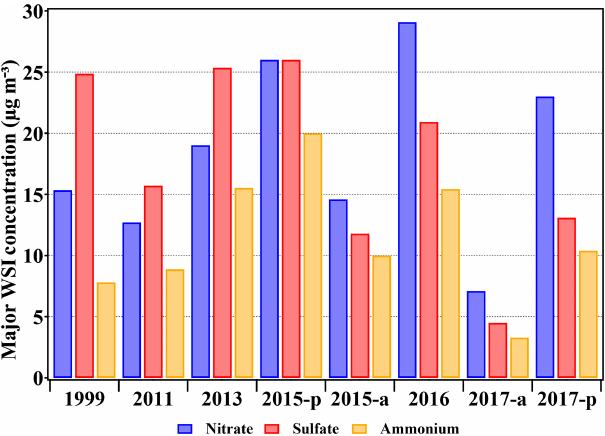
Figure 5. Ratio N-to-S and Ratio A-to-S calculated from the averaged data reported in representative research articles. Only the data in pollution episodes are chosen for